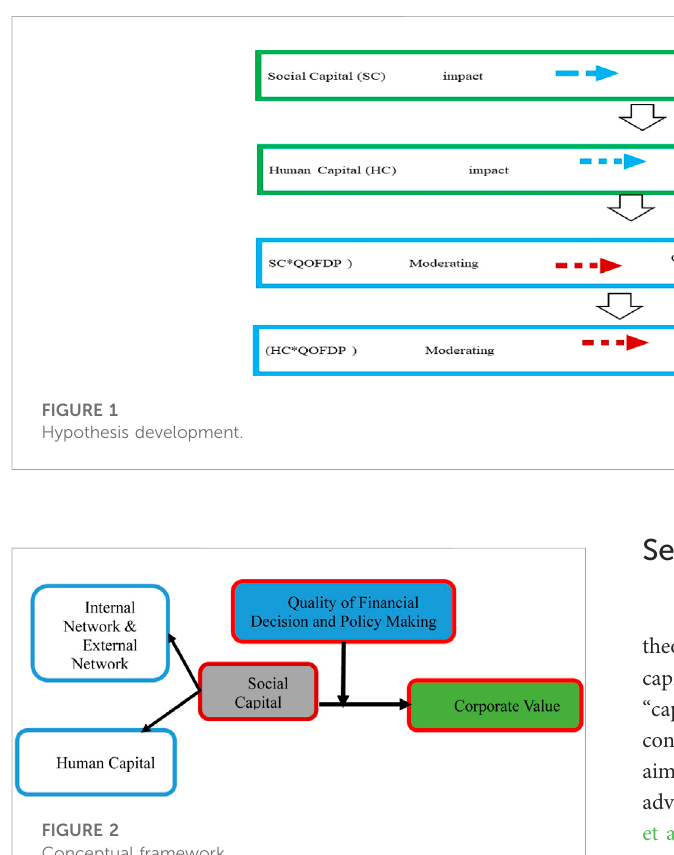
FIGURE 2 Conceptual